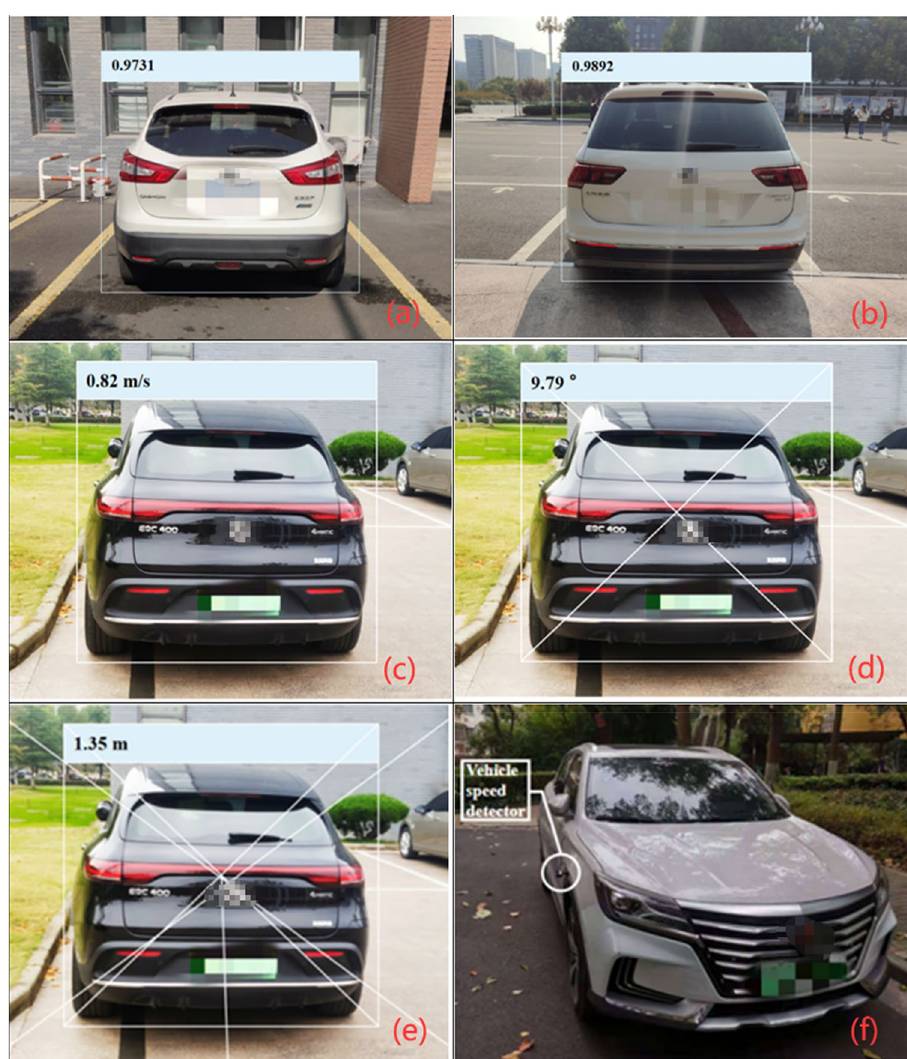
detector is used to detect the actual vehicle and can accurately detect its driving speed and